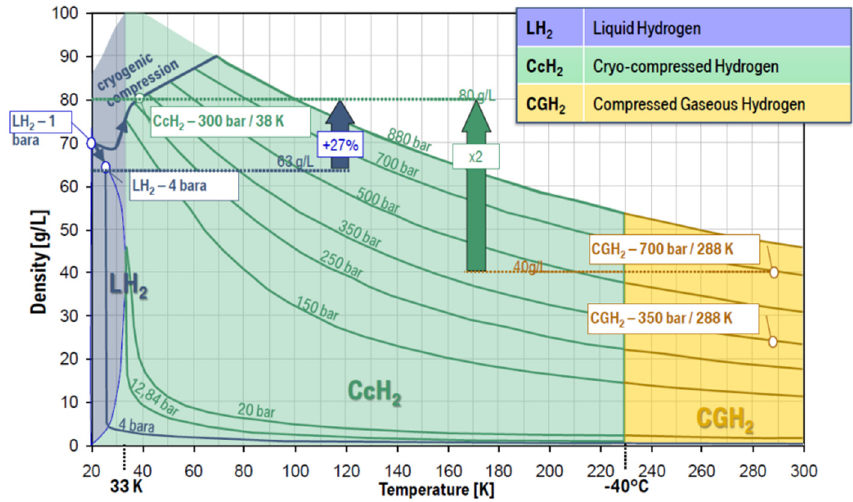
Figure 5. Hydrogen density versus pressure and temperature from BMW. Reprinted/adapted with permission from Ref. [62], copyright 2017 Elsevier.